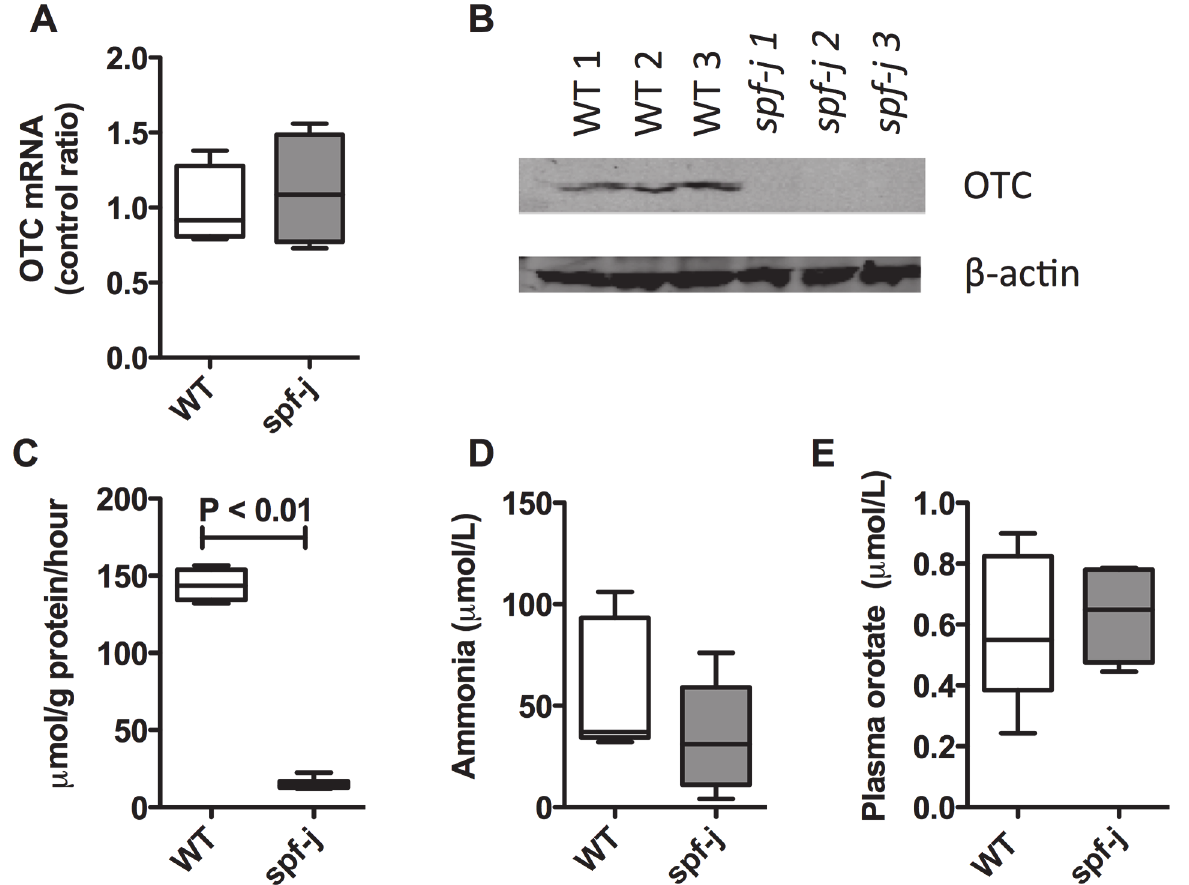
Figure 3. OTC enzyme and biochemical parameters in spf-J males. Spf-J and WT were maintained on a regular chow diet (22% protein) and euthanized at 8 weeks. Blood was collected by retro-orbital bleeding with plasma separated and stored at − 80°C until use. Tissues were snap frozen and stored at − 80°C until use. A) mRNA level in spf-J (N = 4) and WT (N = 4) livers. B) Immunoblot of OTC protein. C) OTC enzyme activity in liver homogenates from spf-j (N = 6) and WT (N = 4). D) Plasma ammonia in spf-j (N = 7) and WT (N = 6). E) Plasma orotate in spf-j (N = 5) and WT (N = 6). Hatched bar indicates P < 0.05. WT –